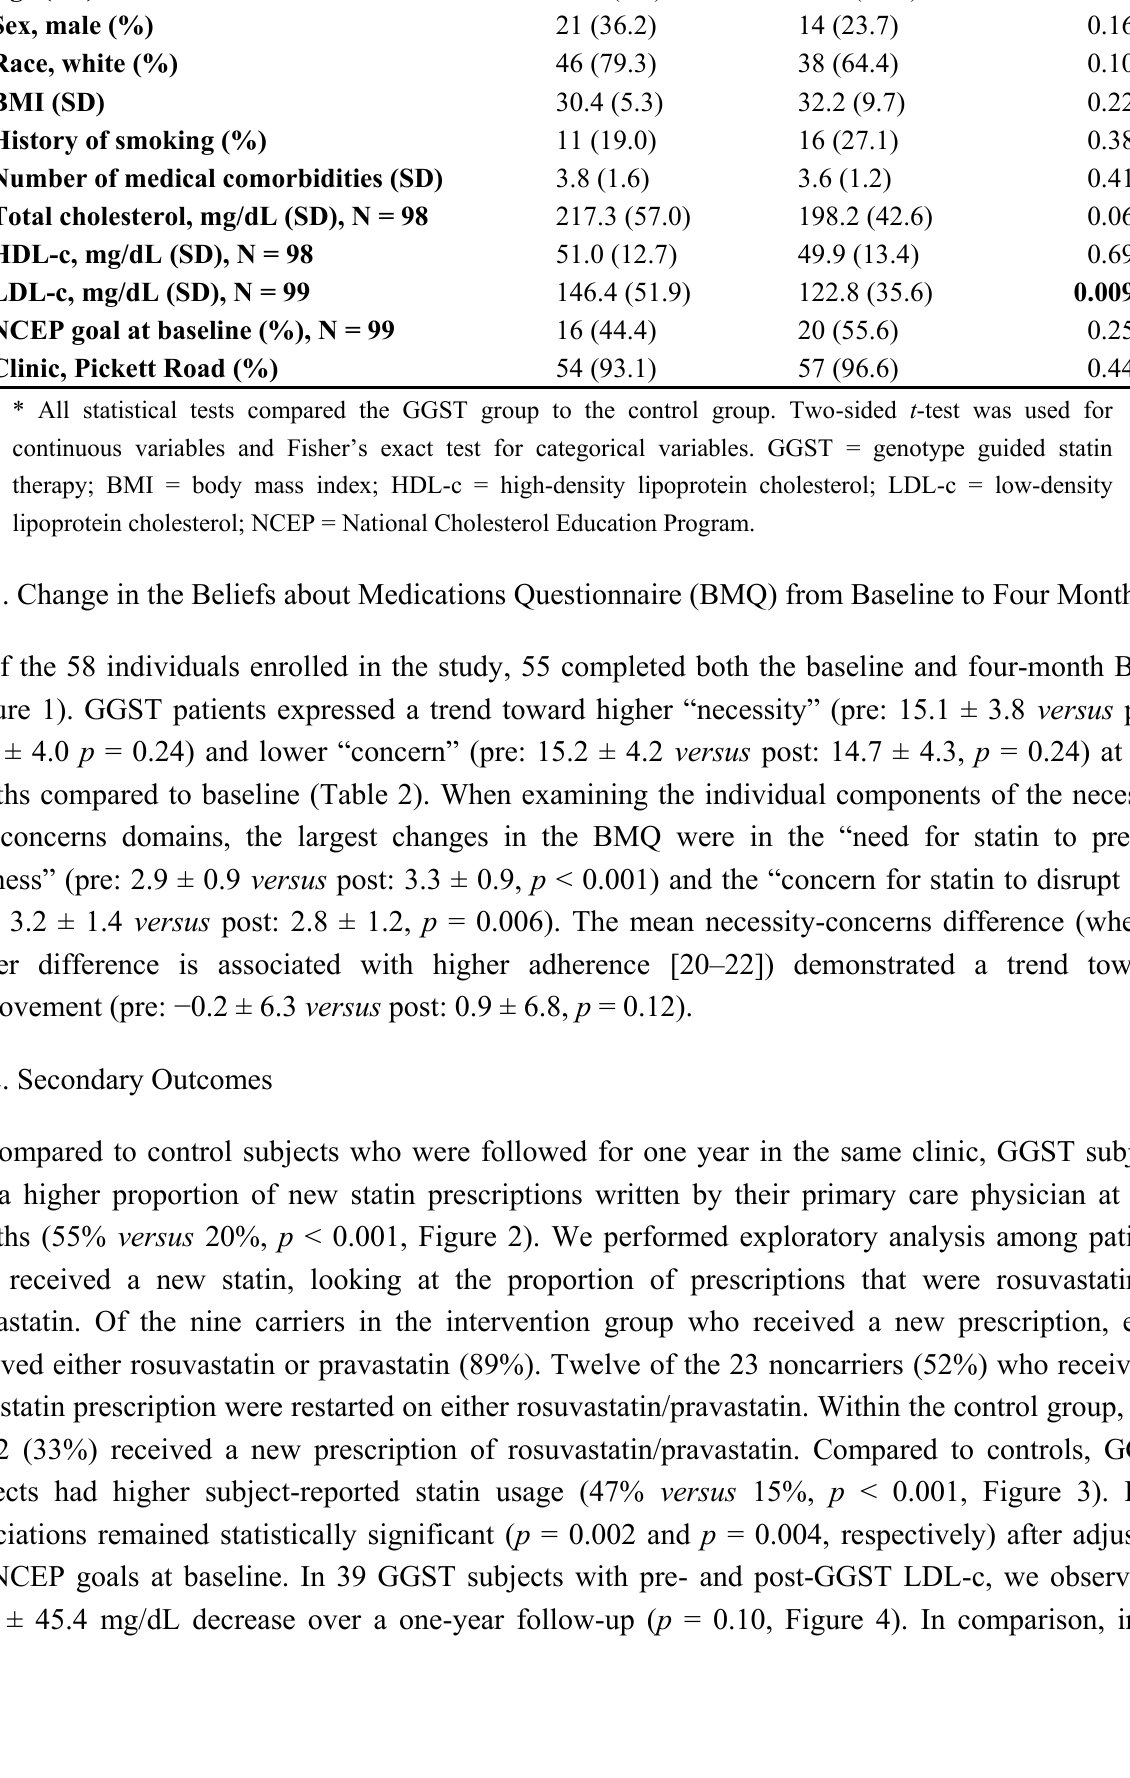
Table 1. Patient characteristics in genotype guided statin therapy (GGST) and control groups. Characteristic GGST (N = 58) Control (N = 59) p* Age (SD) 63.6 (9.0) 21